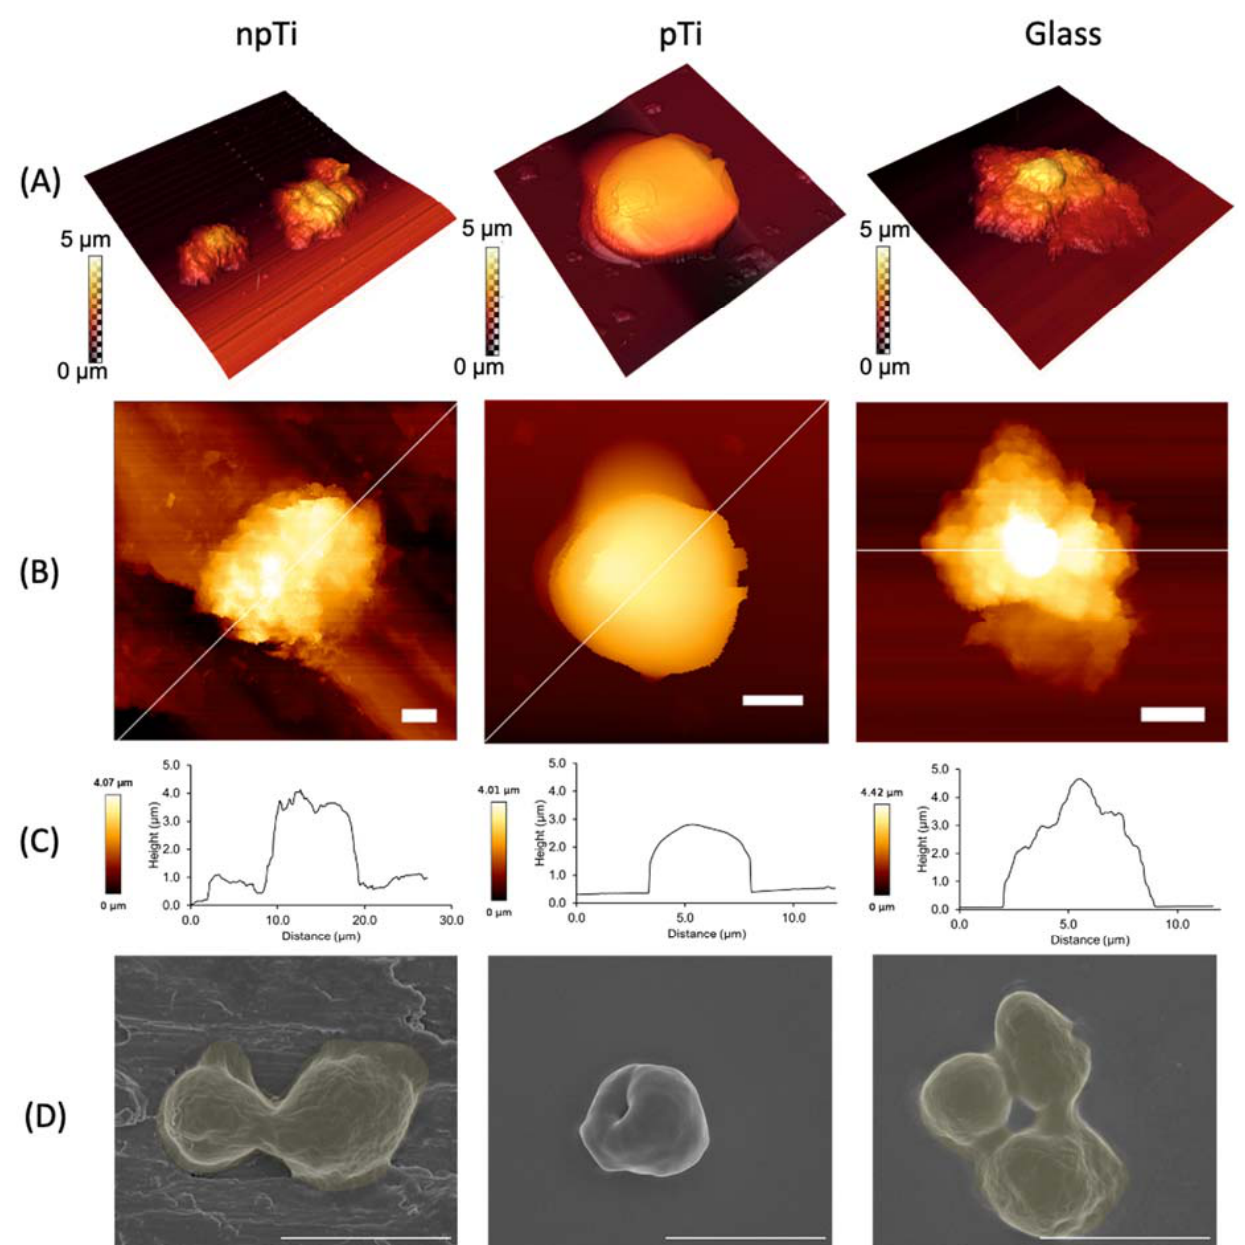
Figure 2. Morphology and topographic profile of C. albicans cells attached onto npTi, pTi, and glass surfaces. ( A ) 3D AFM micrographs of the surface morphology of C. albicans cells. ( B ) 2D AFM micrographs demonstrated the shape and orientation of cell attachment on different surfaces. Scale bars are 2 µm. ( C ) Corresponding surface line profiles revealed the dimension of C. albicans cells on npTi, pTi, and glass surfaces. ( D ) SEM micrographs showing the surface morphology of attached C. albicans cells after a 3-day incubation period on npTi, pTi, and glass surfaces. Rough EPS layers were detected on attached C. albicans cells on npTi and glass (false-colored yellow). Attached C. albicans cells on pTi were not covered by EPS. Scale bars are 5 µm. Table 1. Analysis of C. albicans cell mechanical properties on npTi, pTi, and glass surfaces a . npTi pTi Glass